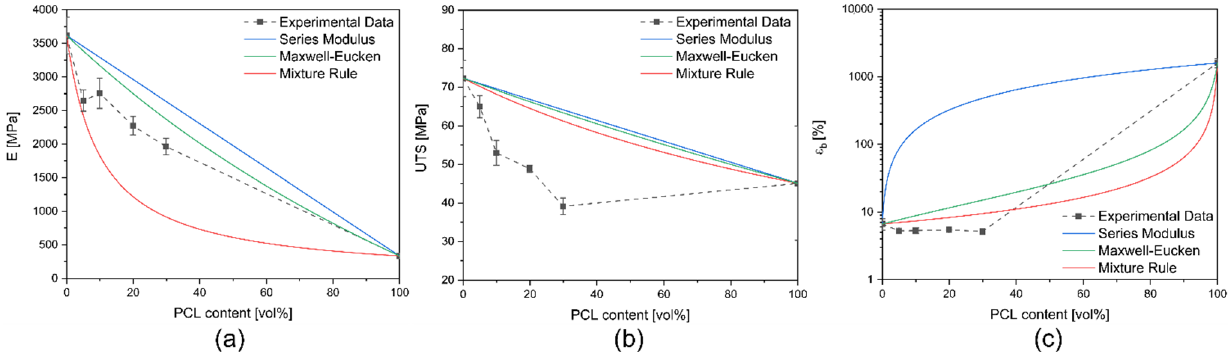
Figure 9. Results of quasi-static tensile tests on the prepared PA6/PCL blends. ( a ) Elastic modulus, ( b ) ultimate tensile strength, ( c ) elongation at break.